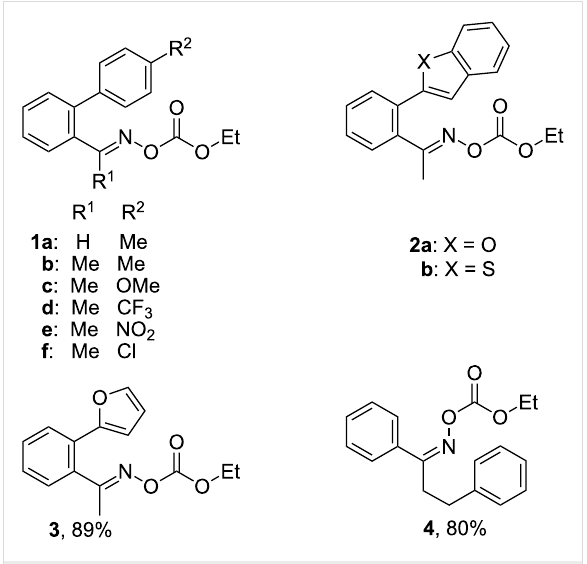
Figure 1: O -Ethoxycarbonyl oximes